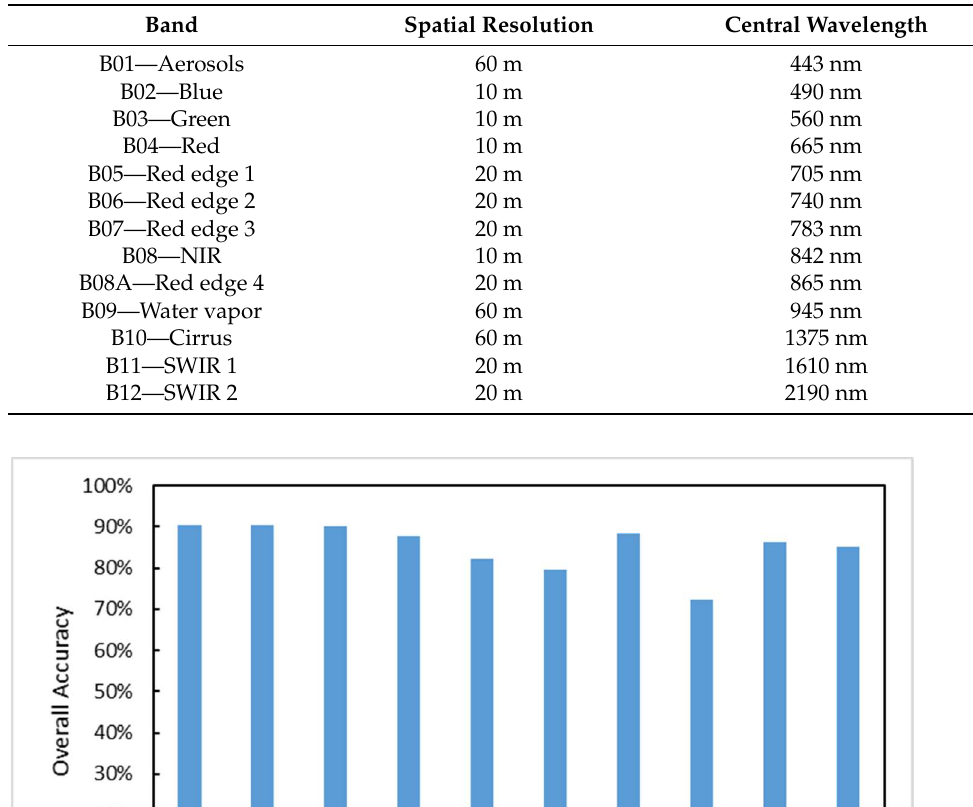
Table 7. All 13 bands covered by Sentinel-2 (cid:48) s multispectral imager (MSI).